Question: What style of plot is this figure drawn as?
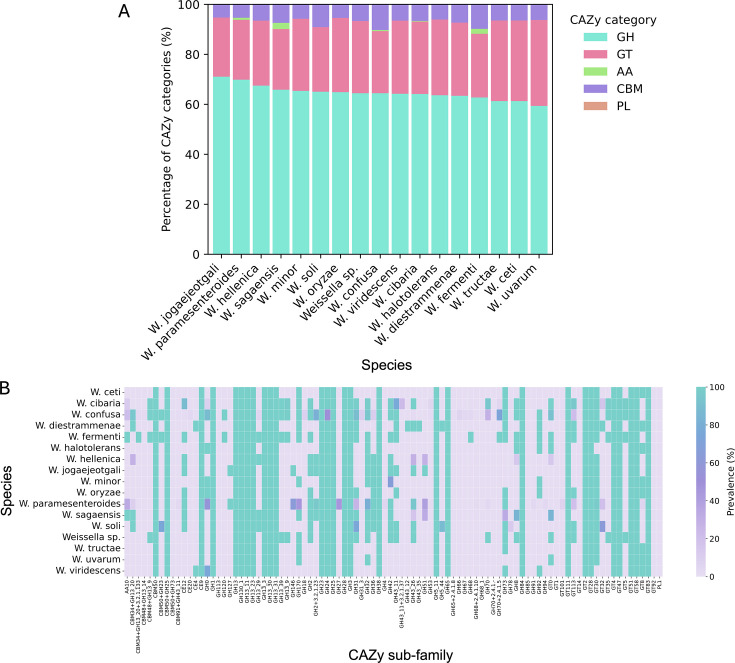
Answer: heatmap